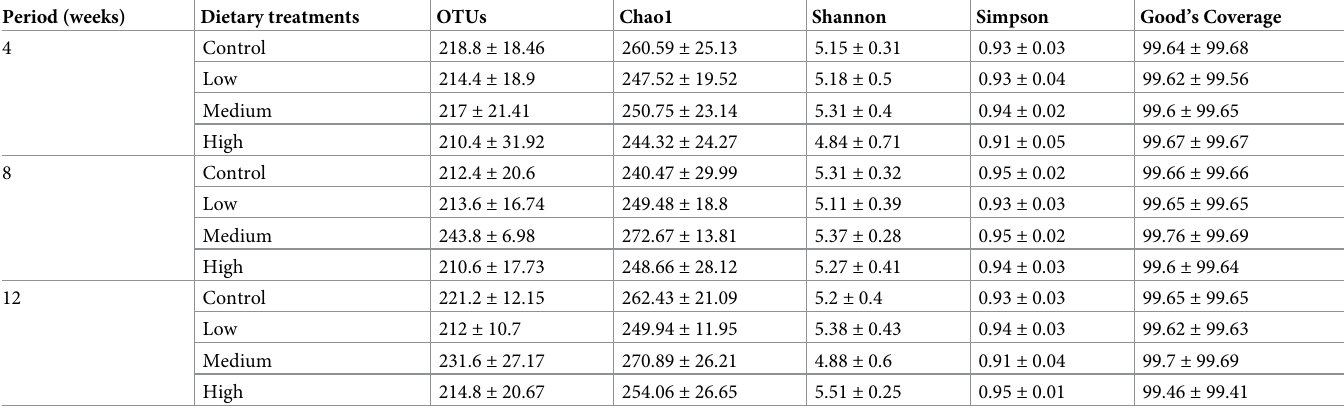
Table 6. Number of OTUs and diversity indices from rumen of goats fed with increasing levels of lovastatin. Period (weeks) Dietary